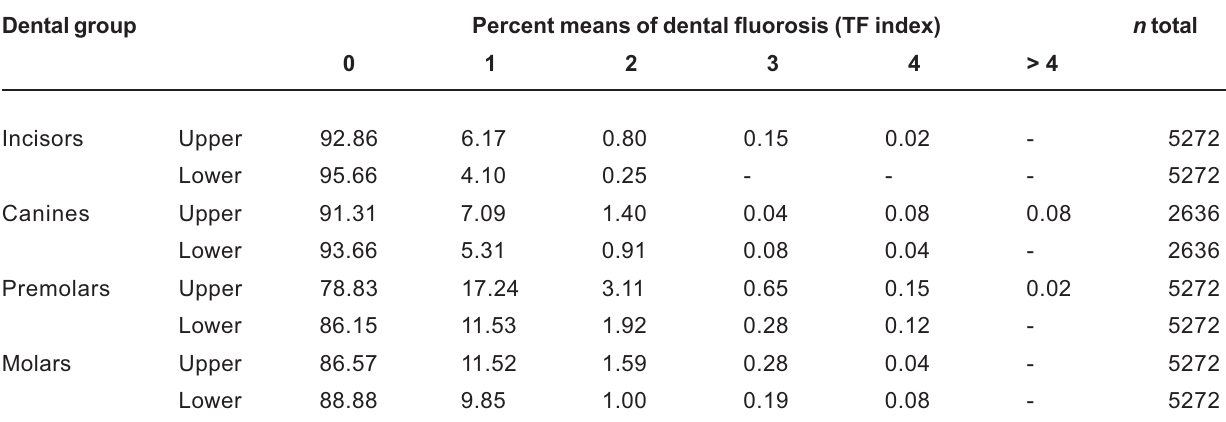
TABLE 3- Percent distribution of dental fluorosis (TF index) according to severity in the different dental groups of the scholars of Bauru, Dental group